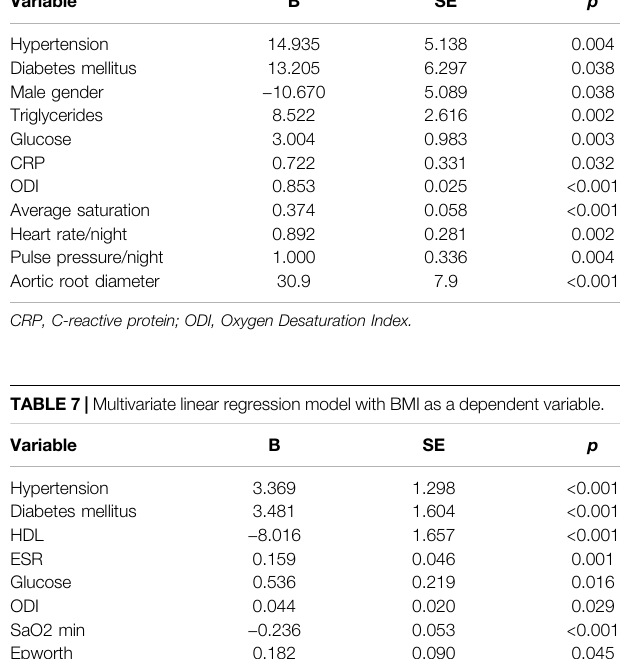
TABLE 6 | Multivariate linear regression model with AHI as a dependent variable. Variable